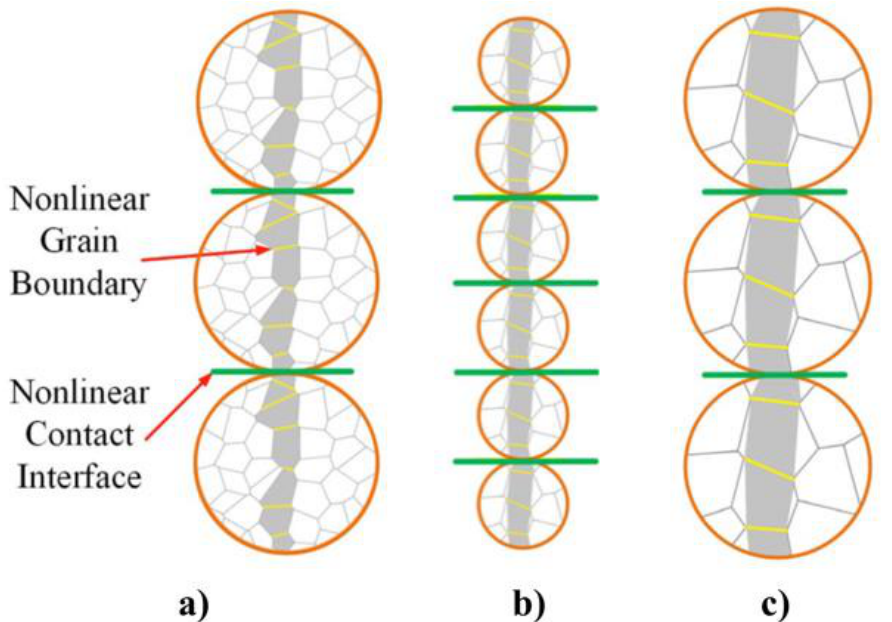
Figure 12. Schematic of conduction paths in nonlinear composites. ( a ) Large diameter particle with small grain size, ( b ) small diameter particle with small grain size, ( c ) large diameter particle with large grain size. © 2021 IEEE. Reprinted, with permission, from [56].